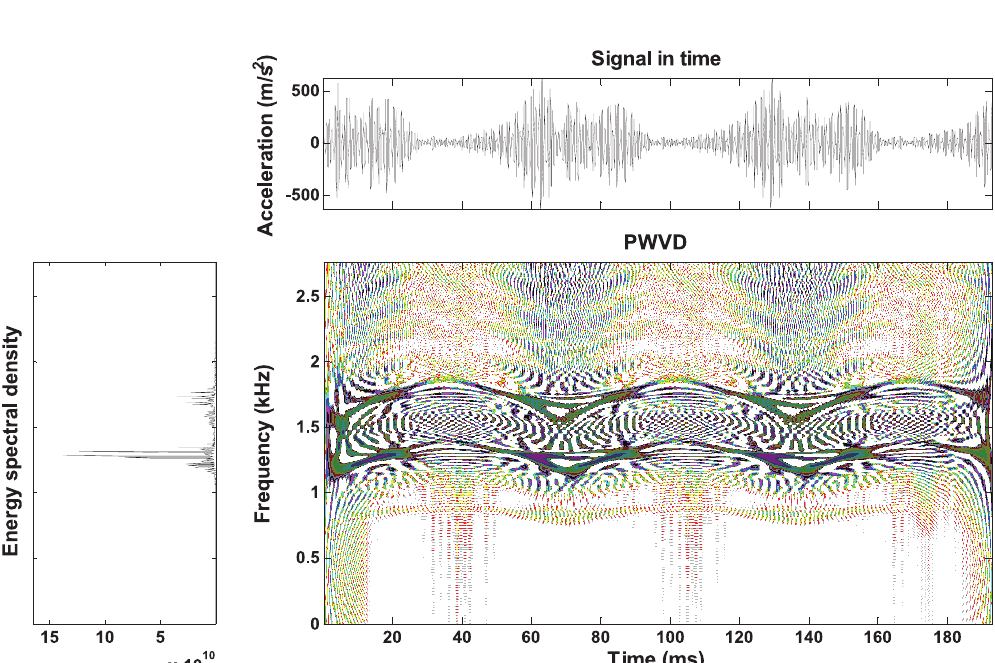
Fig. 14. SWVD of the pinion bearing acceleration for a time varying